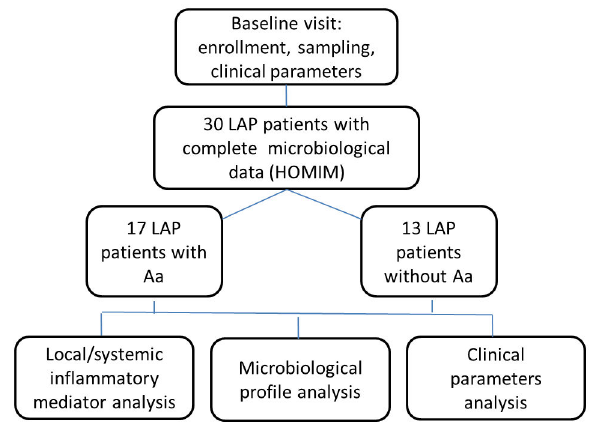
Figure 1. Schematic flowchart of study